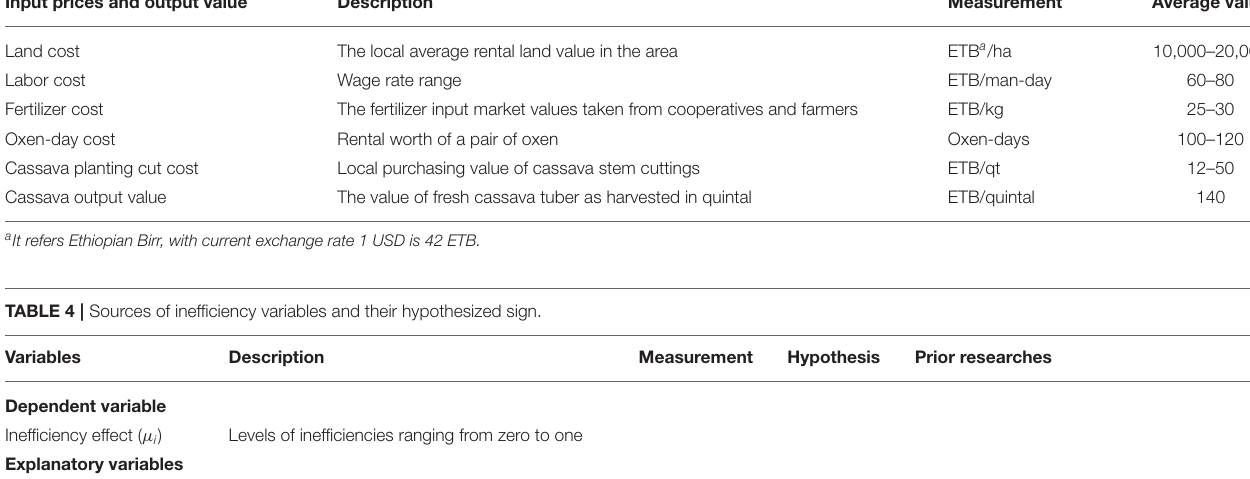
TABLE 3 | Input prices and cassava output value.